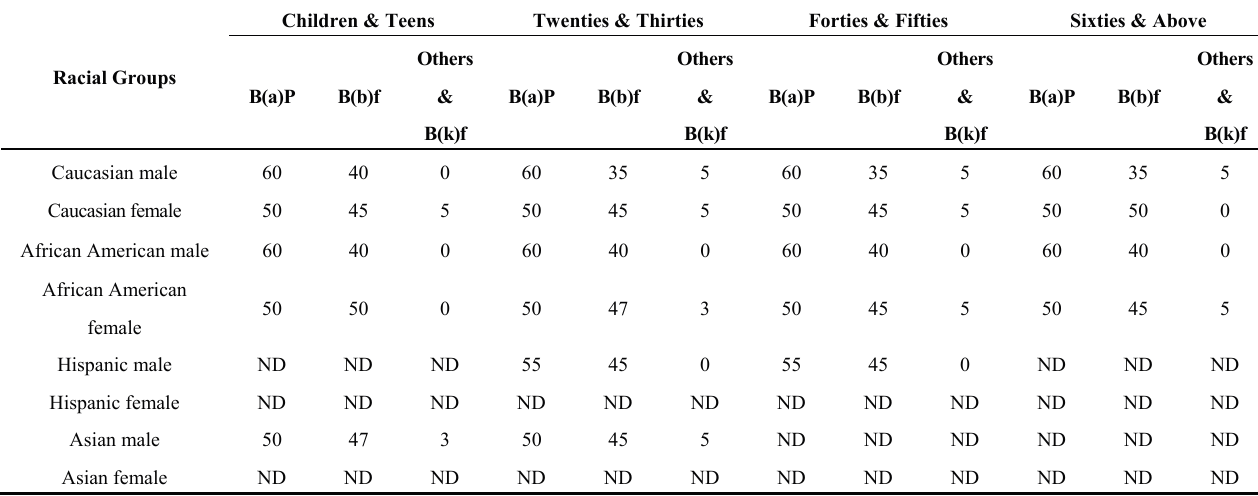
Table 2. Percent composition of PAH residues in serum samples from autopsy